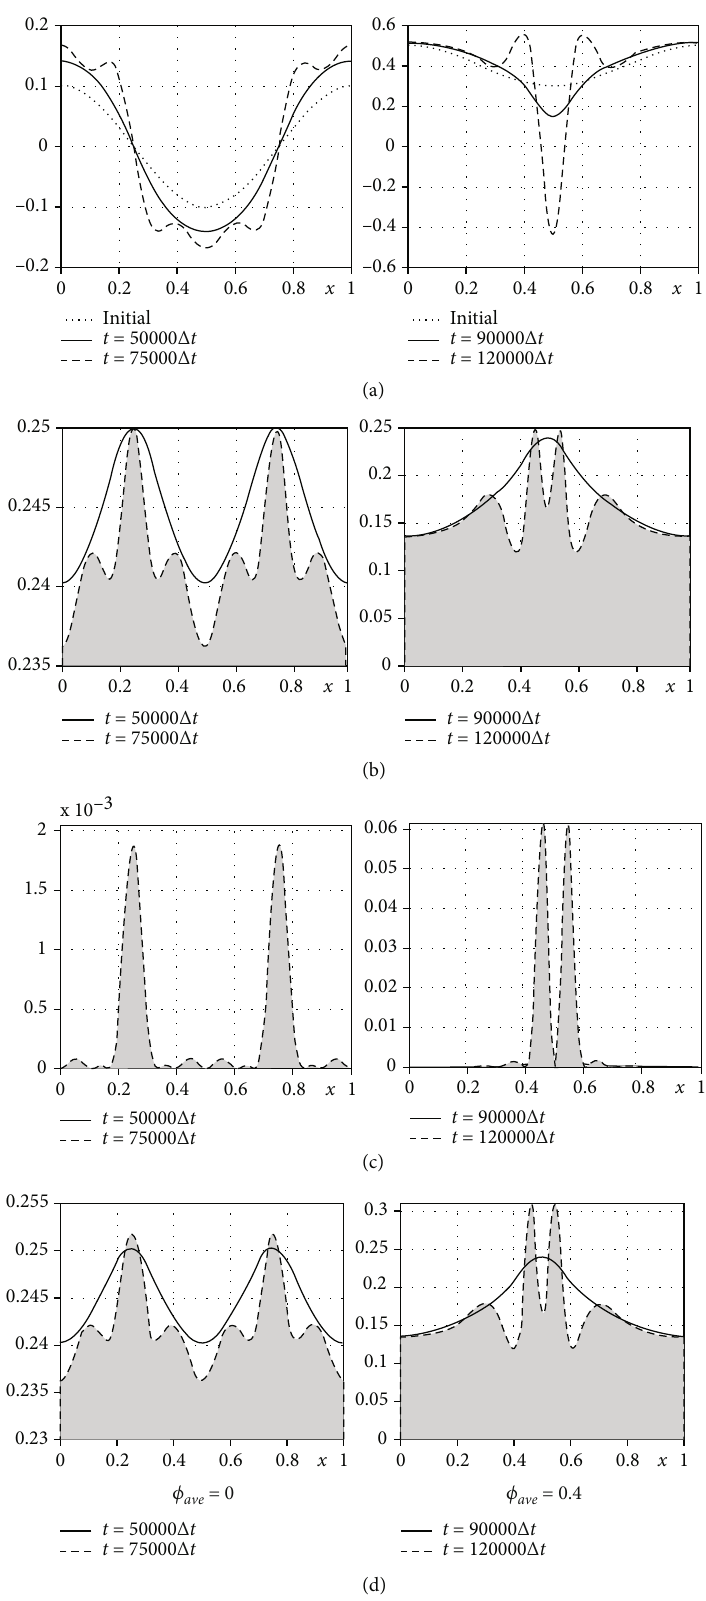
Figure 5: Long- and short-time evolutions: (a) dynamics of the CH equation, (b) – (d) terms of Ginzburg – Landau free energy E ð ϕ Þ : F ð ϕ Þ , ε 2 /2 j ∇ ϕ j 2 , and F ð ϕ Þ + ε 2 /2 j ∇ ϕ j 2 ,